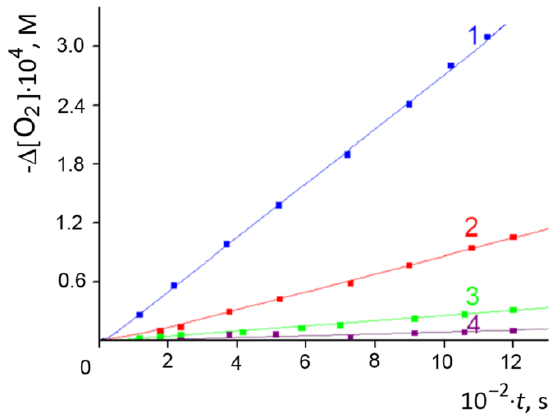
Figure 2. Kinetics of oxygen consumption during the oxidation of adrenaline in phosphate buffer. [AAPH] = 4·10 − 3 M; [Adr] 0 = 1·10 − 3 M; pH = 9.0 (1), 8.2 (2), 7.4 (3), 6.0 (4); 310 K.